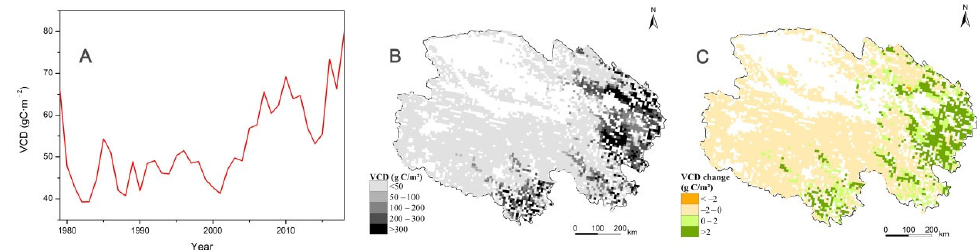
Figure 3. Temporal ( A ) and spatial ( B ) dynamics of vegetation carbon density (VCD) and a map showing this trend ( C ) in the Qinghai grasslands from 1979 to 2018.